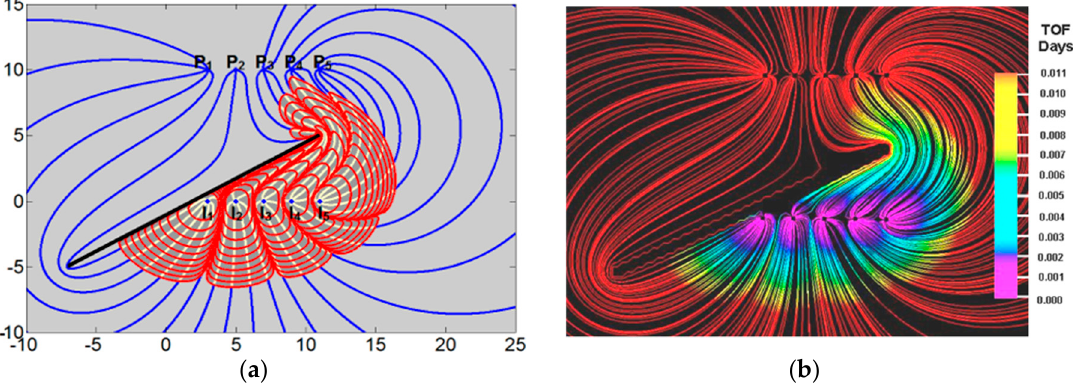
Figure 9. Streamlines and TOFCs for waterflood advance in a homogeneous reservoir with an impervious fault. ( a ) CAM solution. ( b ) Eclipse solution. Reproduced with permission from [26].